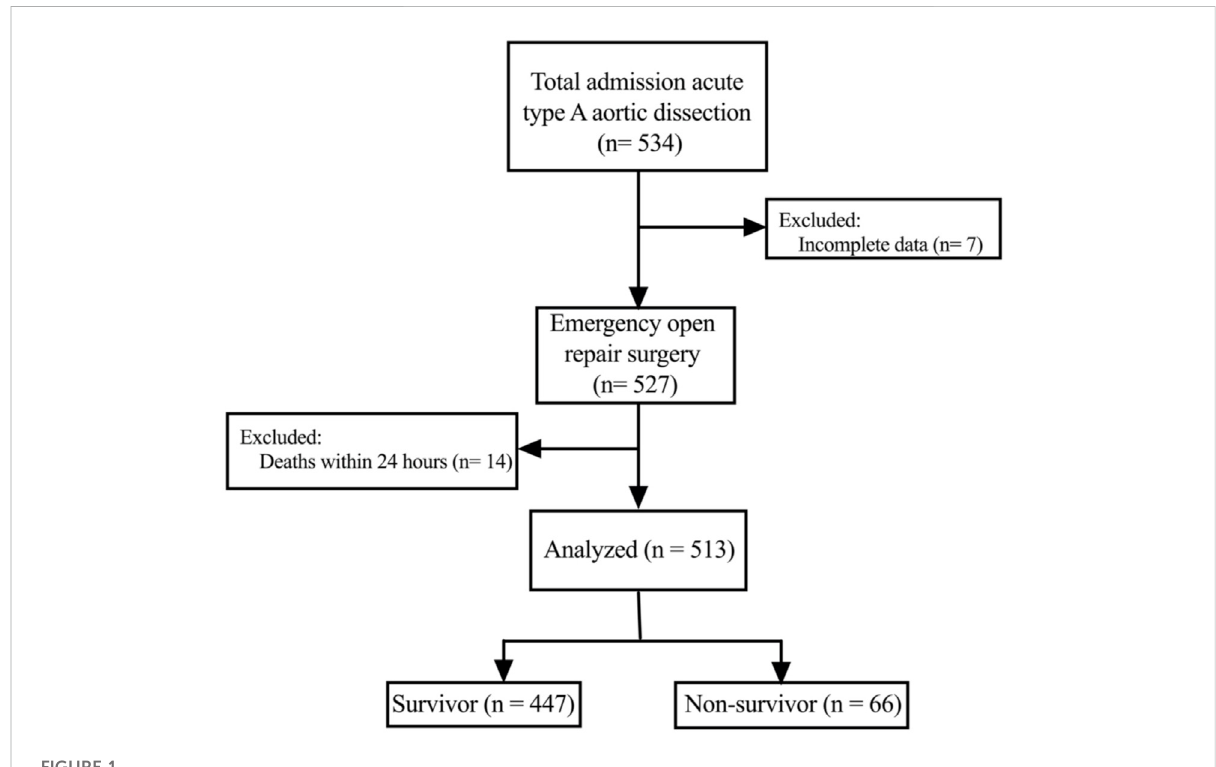
FIGURE 1 Flowchart of the patient